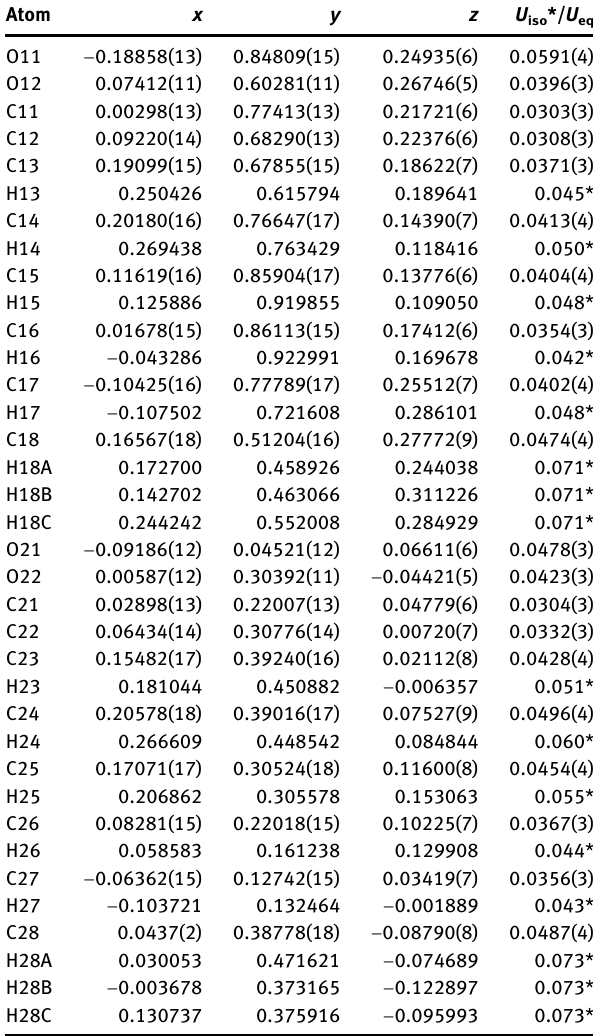
Table  : Fractional atomic coordinates and isotropic or equivalent isotropic displacement parameters (Å  ).